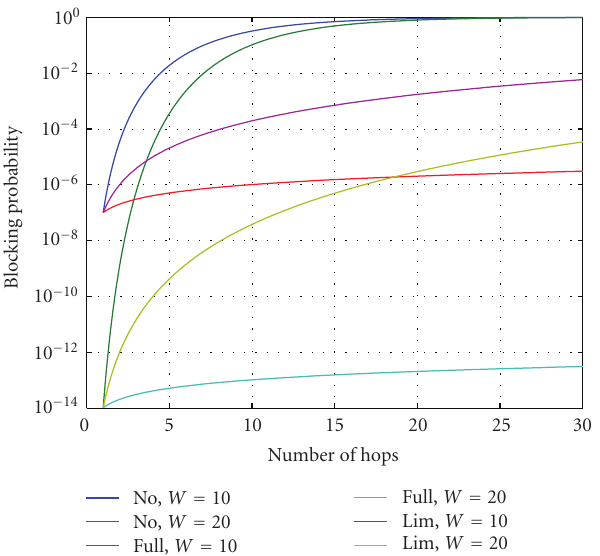
Figure 4: The blocking probability P b = f ( H ), ρ = 0 . 2, k = 3, and F = 1.